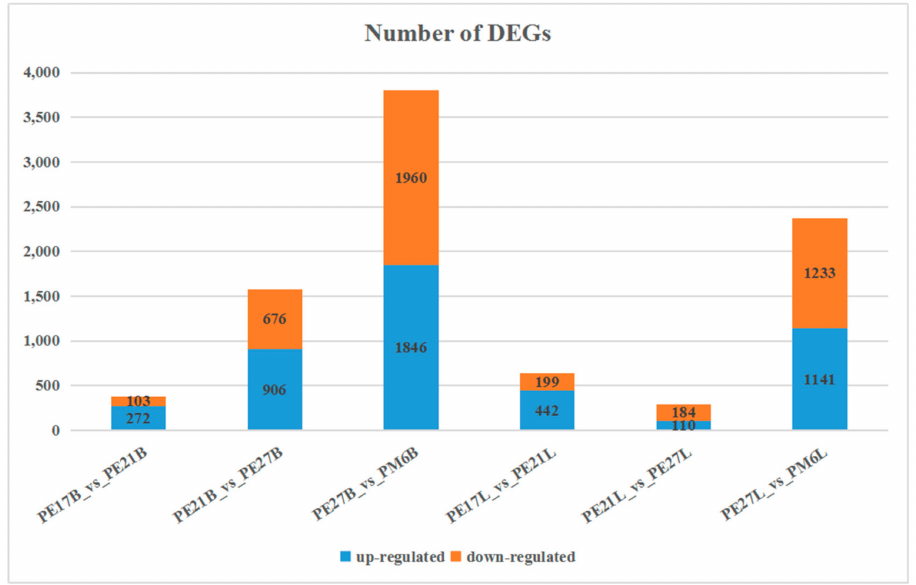
Figure 3. Number of DEGs during skeletal muscle development in Pekin duck.